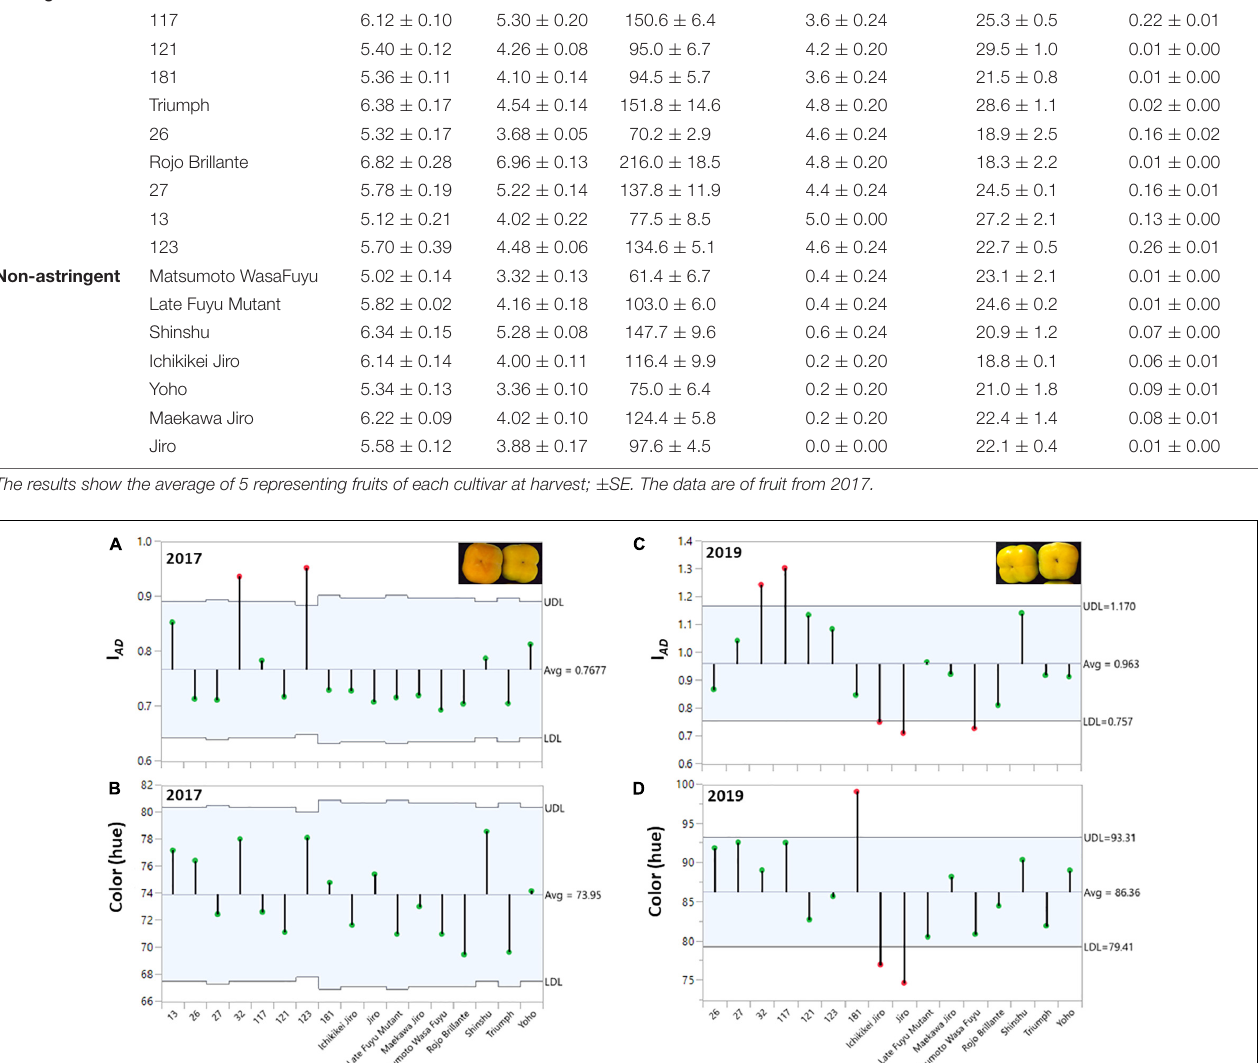
cultivars examined belong to one group and the other group includes all the astringent Chinese